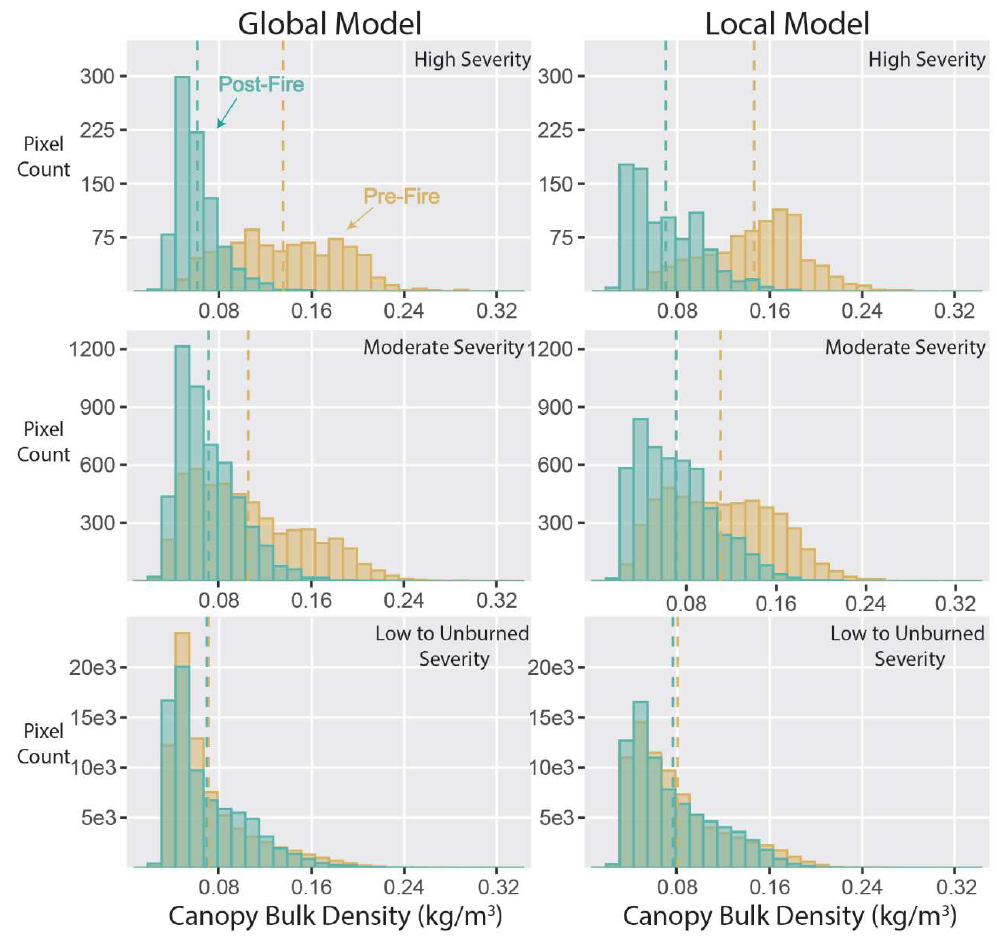
Figure 13. Comparison of pre- and post-fire, global and local (Ochoco) model predictions for canopy bulk density in high ( top row ), moderate ( middle row ), and low to unburned ( bottom row ) fire severity classes for the Corner Creek Fire. Vertical dotted lines depict the mean prediction value.